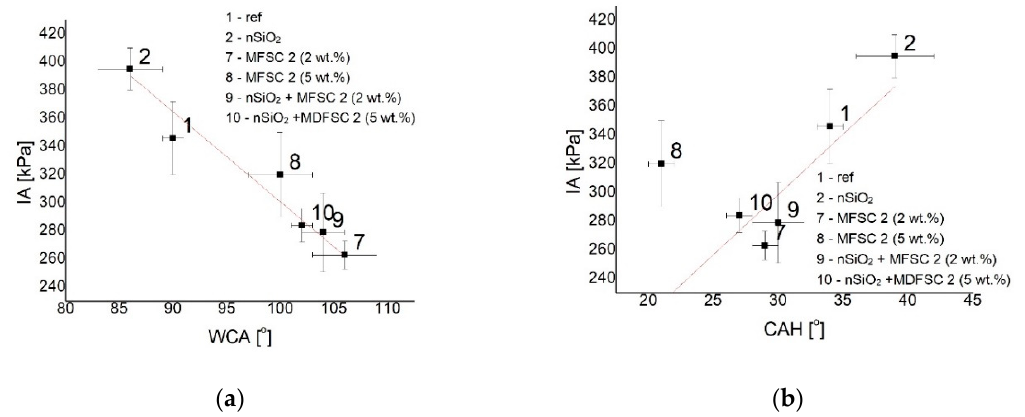
Figure 8. Relationship of IA as a function of ( a ) WCA and ( b ) CAH for samples modified with MFSC 2.